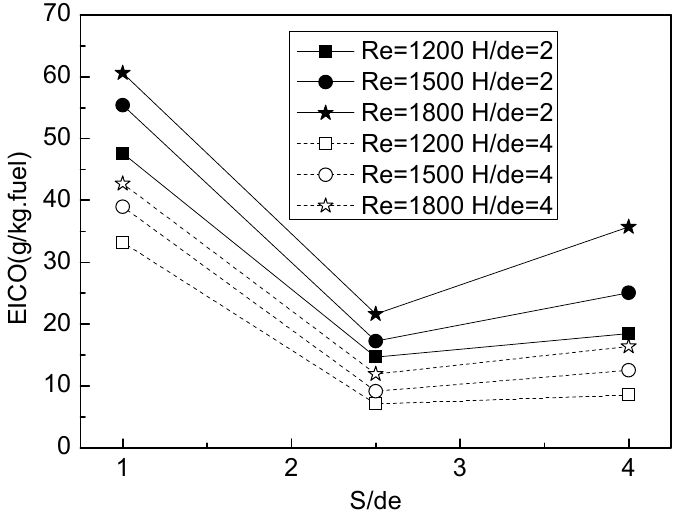
Figure 5. EICO of slot LPG premixed flame array at different conditions.